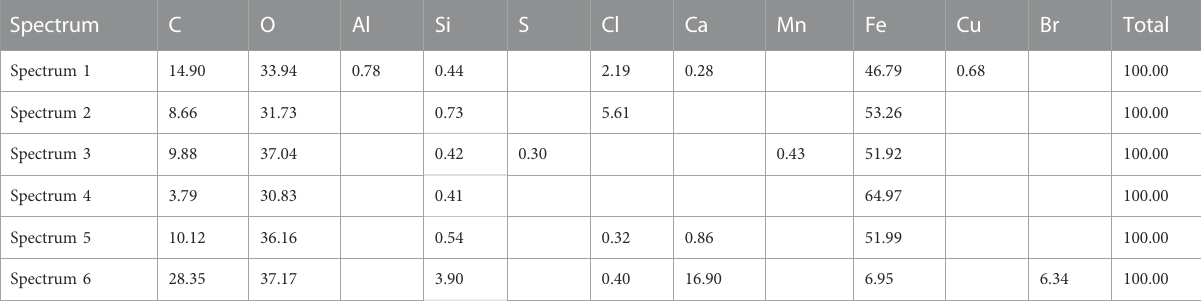
TABLE 2 Elemental composition (in %) of the deposit inside the